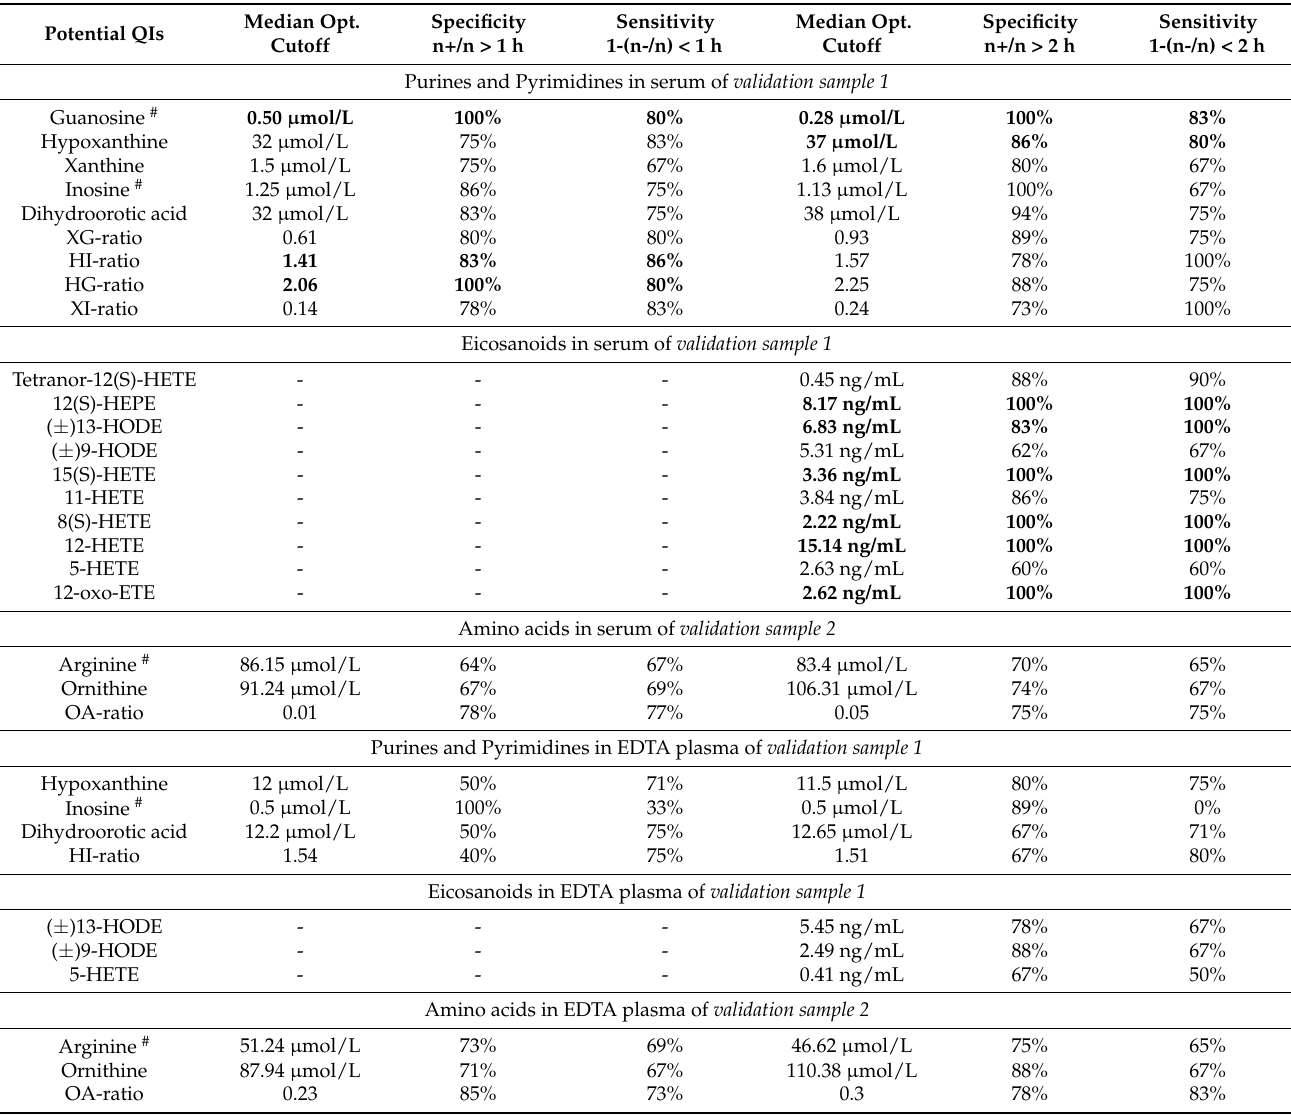
Table 1. Accuracy of all potential QIs for discrimination of TTC ≤ 1 h and 2 h in validation samples of healthy volunteers. Potential QIs